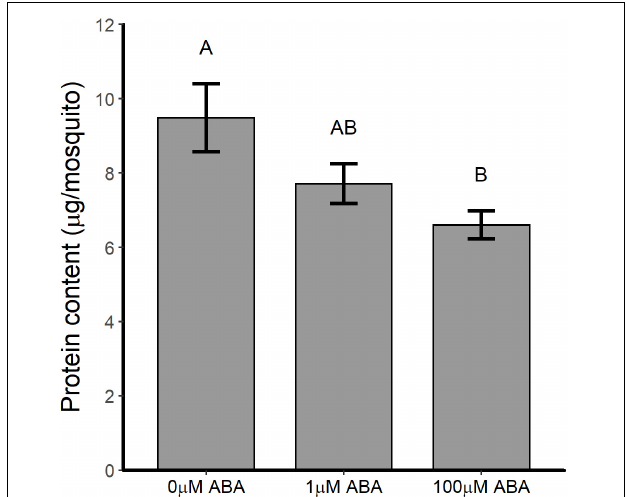
FIGURE 4 | ABA treatment of larval A. stephensi reduced the protein content of newly eclosed adult females. Females emerged from larvae treated with 1 µ M ABA exhibited a trend toward reduced protein content relative to controls (Tukey p = 0.214). Females emerged from larvae treated with 100 µ M ABA exhibited reduced protein content relative to controls (Tukey p = 0.047), but were not significantly different from females emerged from larvae treated with 1 µ M ABA (Tukey p = 0.493). Each biological sample was analyzed in triplicate to confirm assay reproducibility. Data from three biological replicates were combined for analysis and are shown as mean ± SEM. Different capitalized letters indicate significant differences among controls and